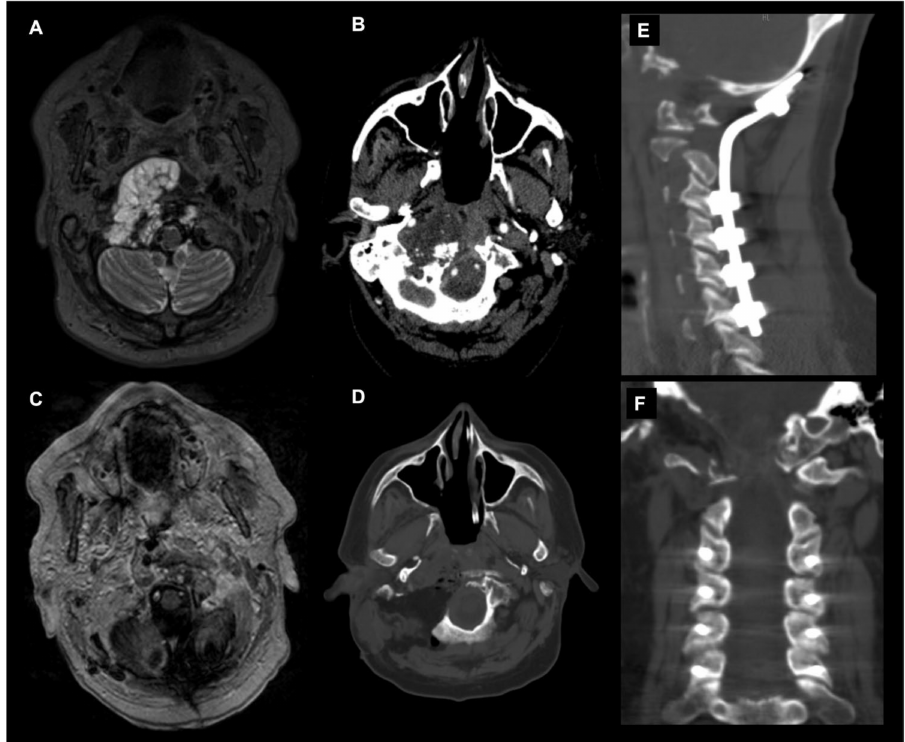
Figure 6. Combined endoscopic endonasal approach and far-lateral transcondylar and petro-occipital trans-sigmoid approach to recurrent CVJ chordoma and subsequent occipitocervical fixation. Axial T2-weighted MR image ( A ) and angio CT scan ( B ) showing a recurrent predominantly right cran- iovertebral junction chordoma. The chordoma infiltrates the rhinopharynx, C0-C1-C2 joint complex and the entire right occipital condyle. A combined endoscopic endonasal approach associated with far-lateral transcondylar and petro-occipital trans-sigmoid approach has been performed. ( C ) Axial postoperative T1-weighted after contrast injection image and ( D ) noncontrast CT scan disclosed a gross total resection with the destruction of the right clival–atlo–axial joint. An occipital-cervical fixation was therefore postoperatively planned and performed ( E , F